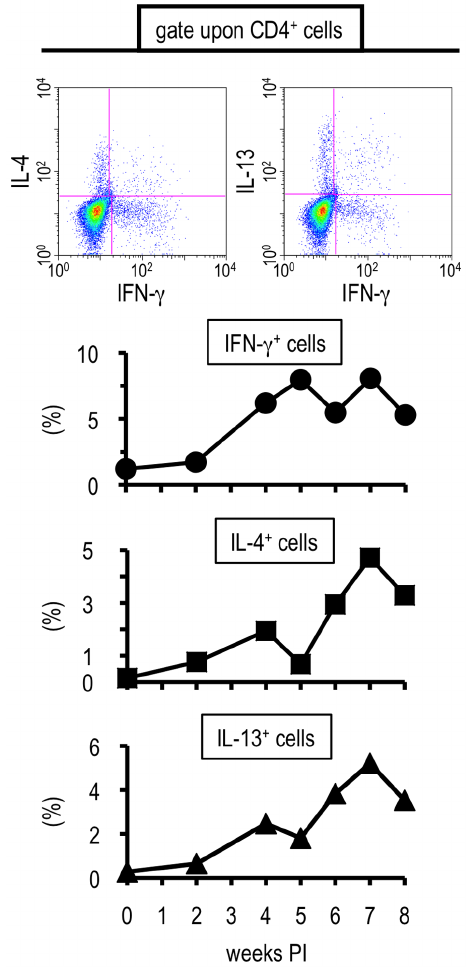
Figure 2. Th1 cells were induced in early and Th2 cells in late phase in the liver. Hepatic lymphocytes were isolated from S. mansoni -infected BALB/c mice at indicated time points, and their potential for producing IFN- c , IL-4, or IL-13 was analyzed by ICS upon TCR ligation. Insets at the top represent one example using liver lymphocytes prepared at 4 weeks PI are shown. The percentages represent the proportions in CD4-positive population. Similar results were obtained in three independent